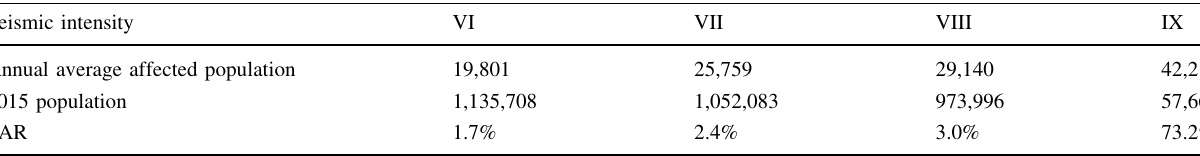
Table 3 Affected population of earthquakes in Tibet, 2015 Seismic